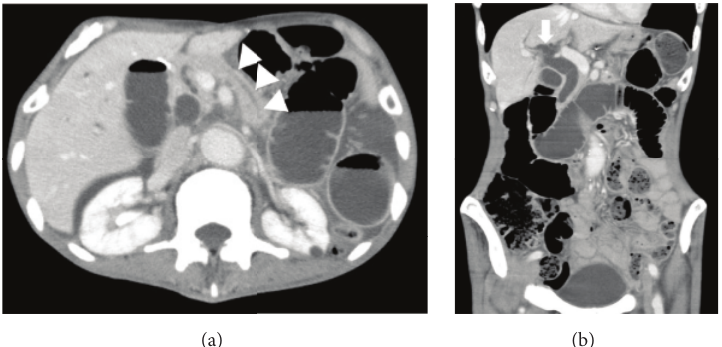
Figure 2: Computed tomography scan images with axial and coronal views showing slight dilation of the main pancreatic duct (arrow heads) and the intrahepatic bile duct (arrow).